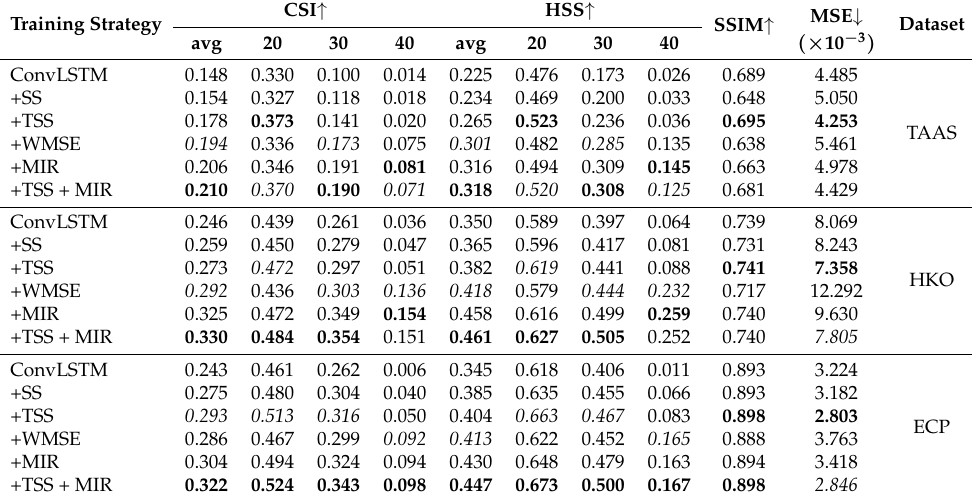
Table 3. Results of ConvLSTM on three datasets. ↑ stands for the higher, which denotes a better result. ↓ stands for the lower, which denotes a better result. The values of 20, 30, and 40 dBZ denote the thresholds of criterion CSI and HSS, and avg is their mean.